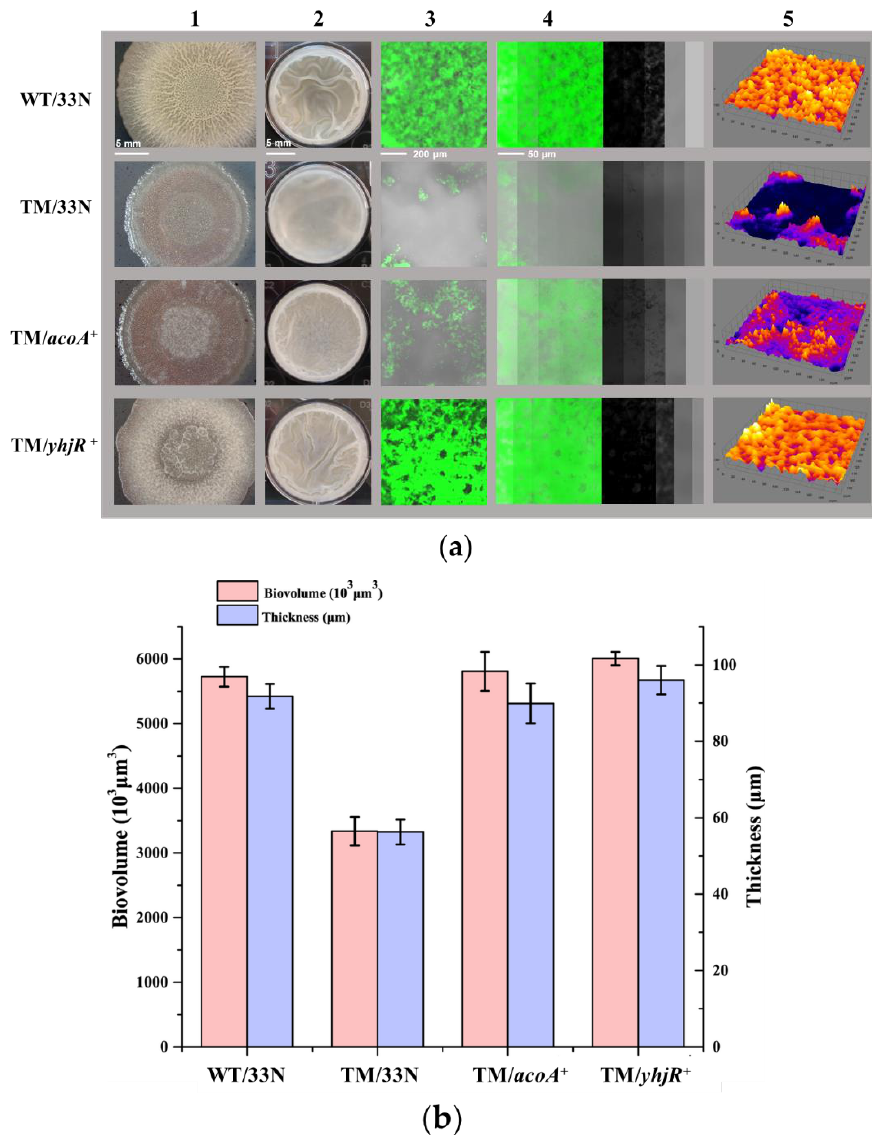
Figure 7. Comparison of the biofilm formation among WT/33N, TM/33N, TM/ acoA + , and TM/ yhjR + . ( a ) The strains of WT/33N, TM/33N, TM/ acoA + , and TM/ yhjR + were grown on the MSgg agar plates for 3 days (Lane 1) and in 24-well microtiter plates supplied with the LBMG liquid medium for 48 h (Lane 2), and biofilms produced by the strains were observed. The images shown in Lane 1 and Lane 2 are the representatives of three independent experiments. Biofilms formed in the microtiter plates were stained with STYO ® 9 and investigated using CLSM. Images of cells attached to the surface are shown in Lane 3. The confocal series were reconstructed through the software IMARIS and a representative image (left) with virtual shadow projection (right) is shown for each strain in Lane 4. The 3D models of biofilms formed by these two strains are shown in Lane 5. The scale bars in Lane 1 –4 represent 5 mm, 5 mm, 200 μm, and 50 μm, respectively. ( b ) Quantification of the thickness and biovolume of the submerged biofilms produced by these four strains. The biovolume (purple) and the thickness (pink) were calculated as the average and ± S.D. of a serious of six images for each strain. As shown in Figure 7a, the strain of TM/ acoA + possessed stronger biofilm